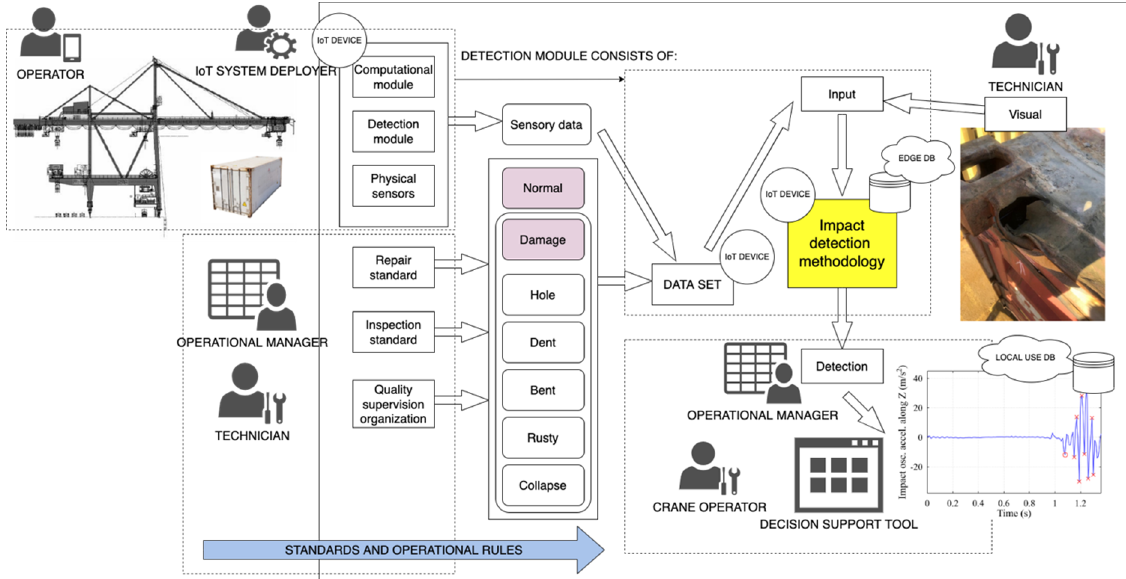
Figure 10. Impacts detection framework used in the study.